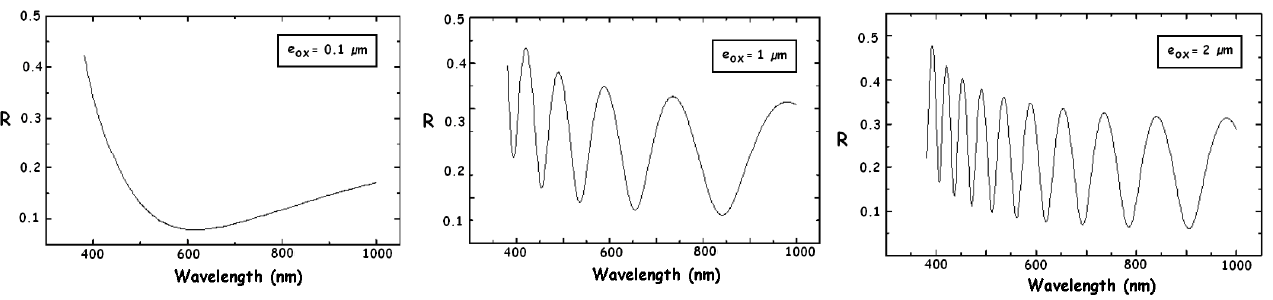
Figure 3. Simulation results of the reflection coefficient R versus wavelength for various SiO thickness e 2 ox